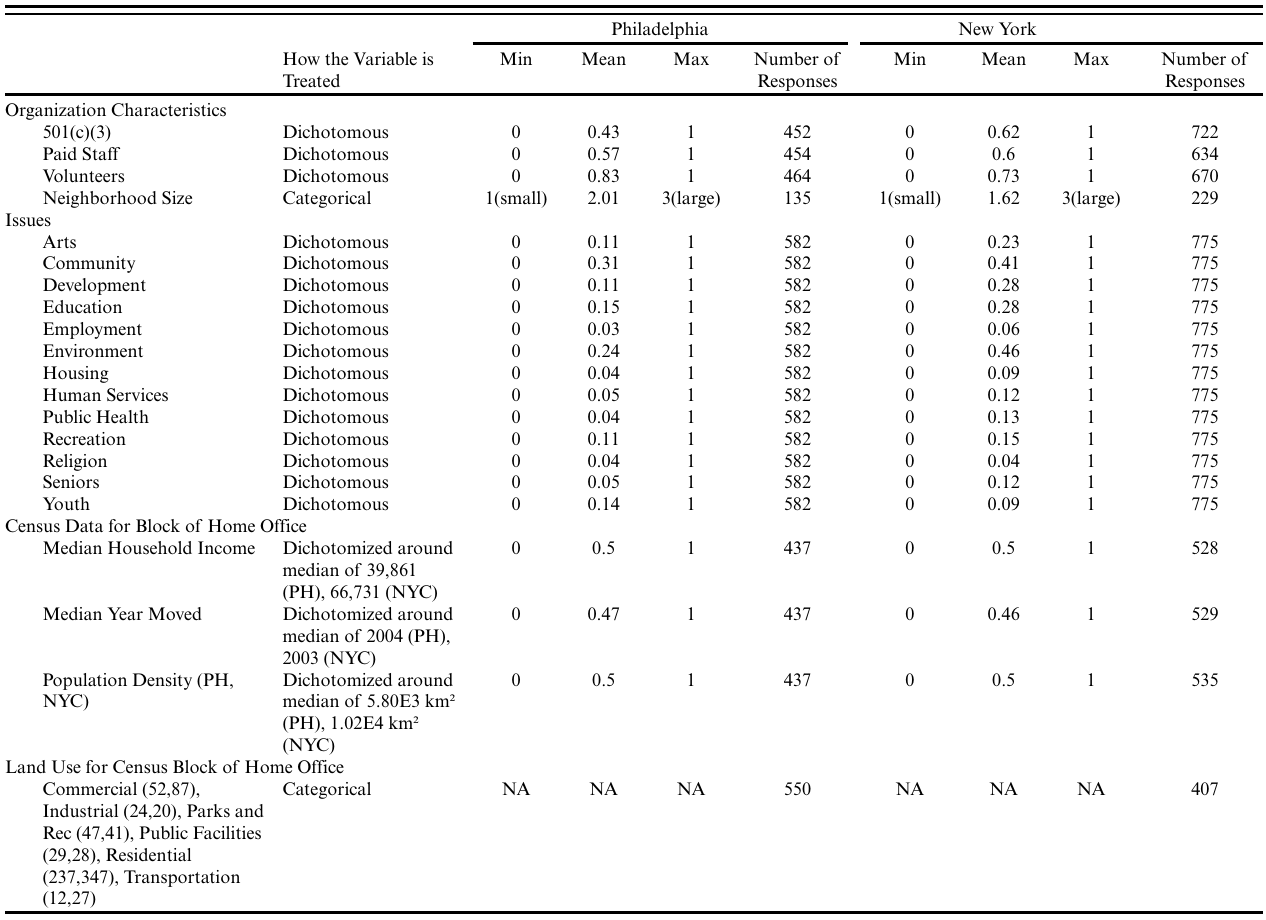
Table 3 . Attribute data for Philadelphia and New York City civic environmental stewardship groups.